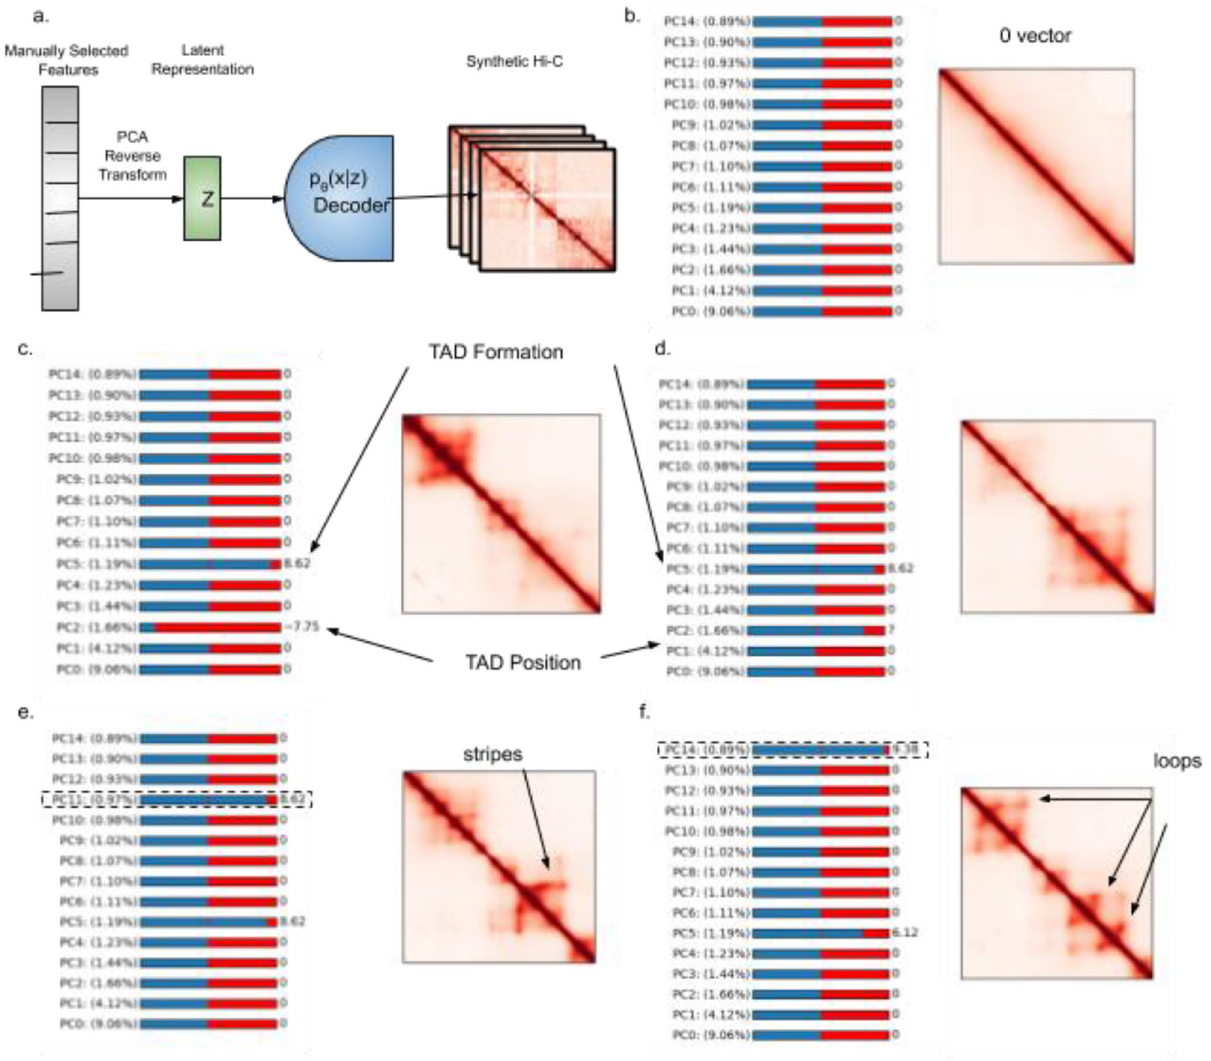
Figure 3. ( a ) Diagram of synthetic Hi-C generation tool, a user tunable zero-centered feature vector is transformed via PCA reverse transform to latent space and then passed through our tuned decoder network. ( b ) The 0 vector corresponds to a purely linear contact map. ( c ) Increasing value of PC5 results in generation of TADs. ( d ) Adjusting value of PC2 shifts position of TADs. ( e ) Adjusting PC11 creates stripes within TADS. ( f ) Adjusting PC14 develops loops within